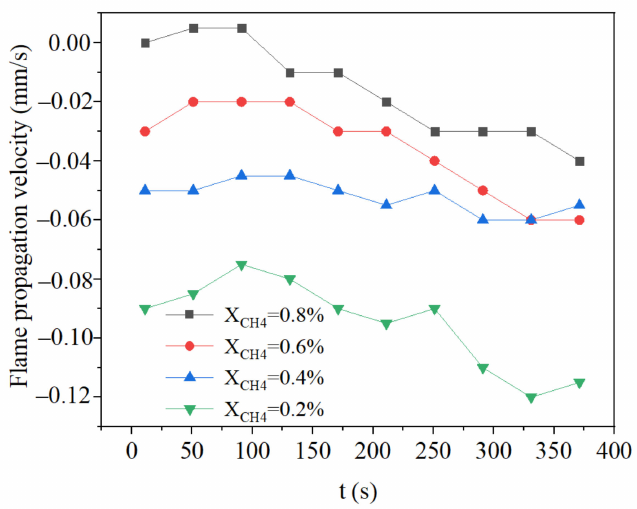
Figure 14. Variation of flame propagation velocity with time at different concentrations with the inlet flow rate of 700 m 3